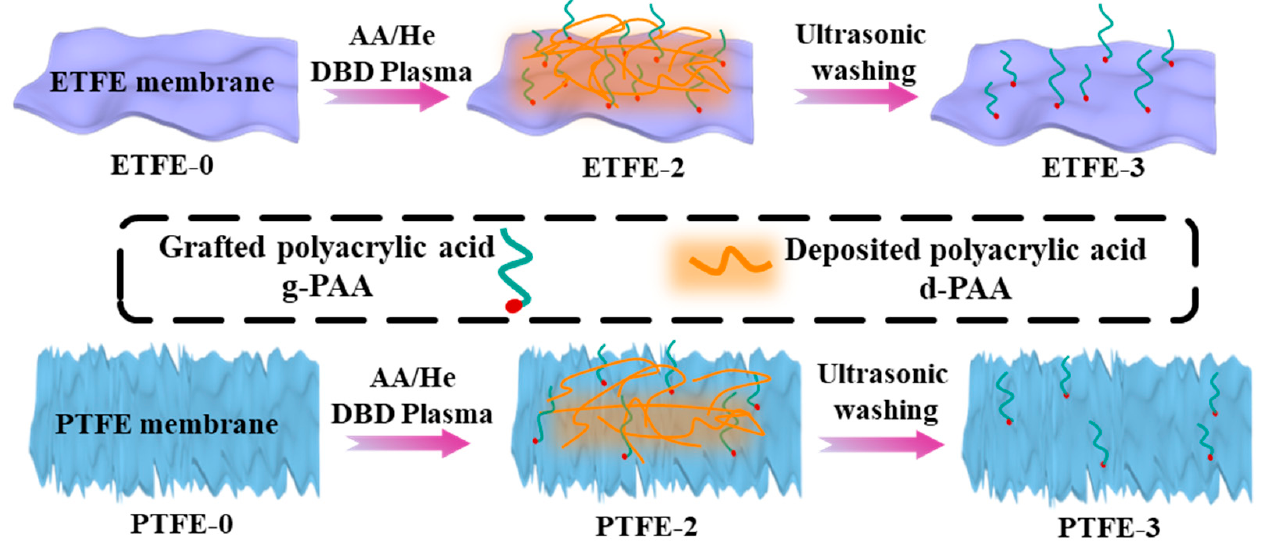
Figure 3. Mechanism of He/AA plasma modifications on ETFE and PTFE membranes.